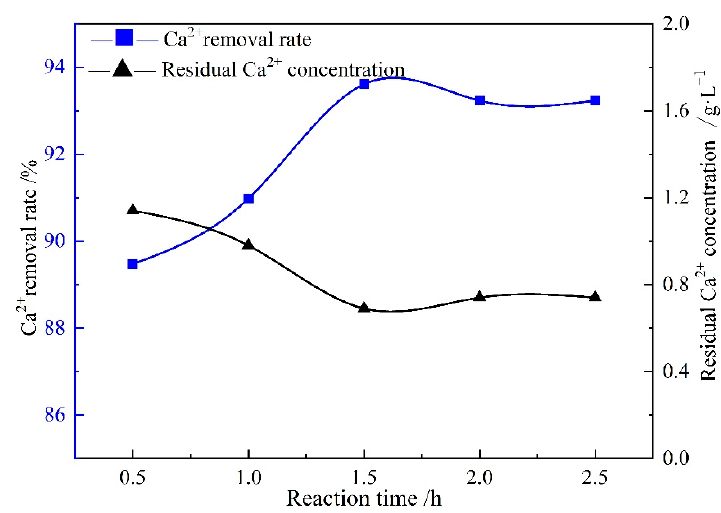
Figure 4. The relationship between reaction time and Ca 2+ removal